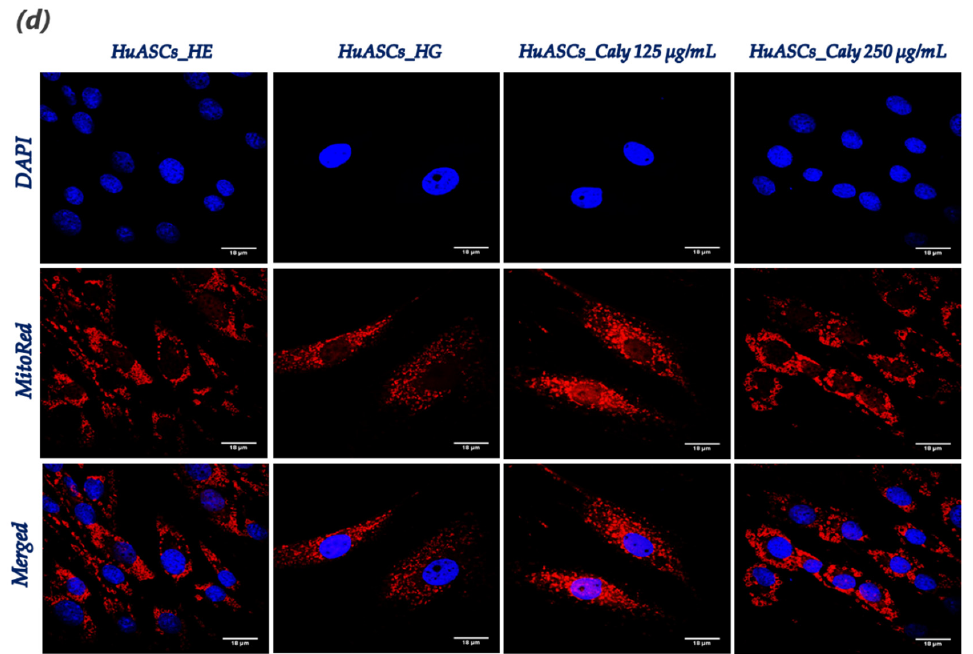
Figure 5. Beneficial effects of total calystegine extract on abnormal mitochondrial dynamics in HuASCs cells cultured under hyperglycaemic conditions. ( a ) Representative dot plots for MUSE MitoPotential analysis. ( b ) Percentage of live and dead cells exhibiting depolarized mitochondria. ( c ) Relative gene expression of mitochondrial fusion and fission associated genes. ( d ) Epi-fluorescent confocal microscope micrographs of MitoRed stained cells; scale bar size 18 µm. Representative data from three independent experiments are shown ± SD (n = 3). An asterisk (*) indicates a comparison of the HG group to the untreated healthy cells. A hashtag (#) indicates a comparison of HG group pre-treated with calystegines to the HG untreated healthy cells. */# p < 0.05, **/## p < 0.01, ***/### p < 0.001. HuASCs_HE: human ASCs healthy untreated cells; HuASCs_HG: hyperglycaemic human ASCs cells exposed to a high concentration of glucose. HuASCs_Caly 125 µg/mL: hyperglycaemic human ASCs cells pre-treated with 125 µg/mL calystegines extracted and exposed to a high concentration of glucose. HuASCs_Caly 250 µg/mL: hyperglycaemic human ASCs cells pre-treated with 250 µg/mL calystegines extracted and exposed to a high concentration of glucose.